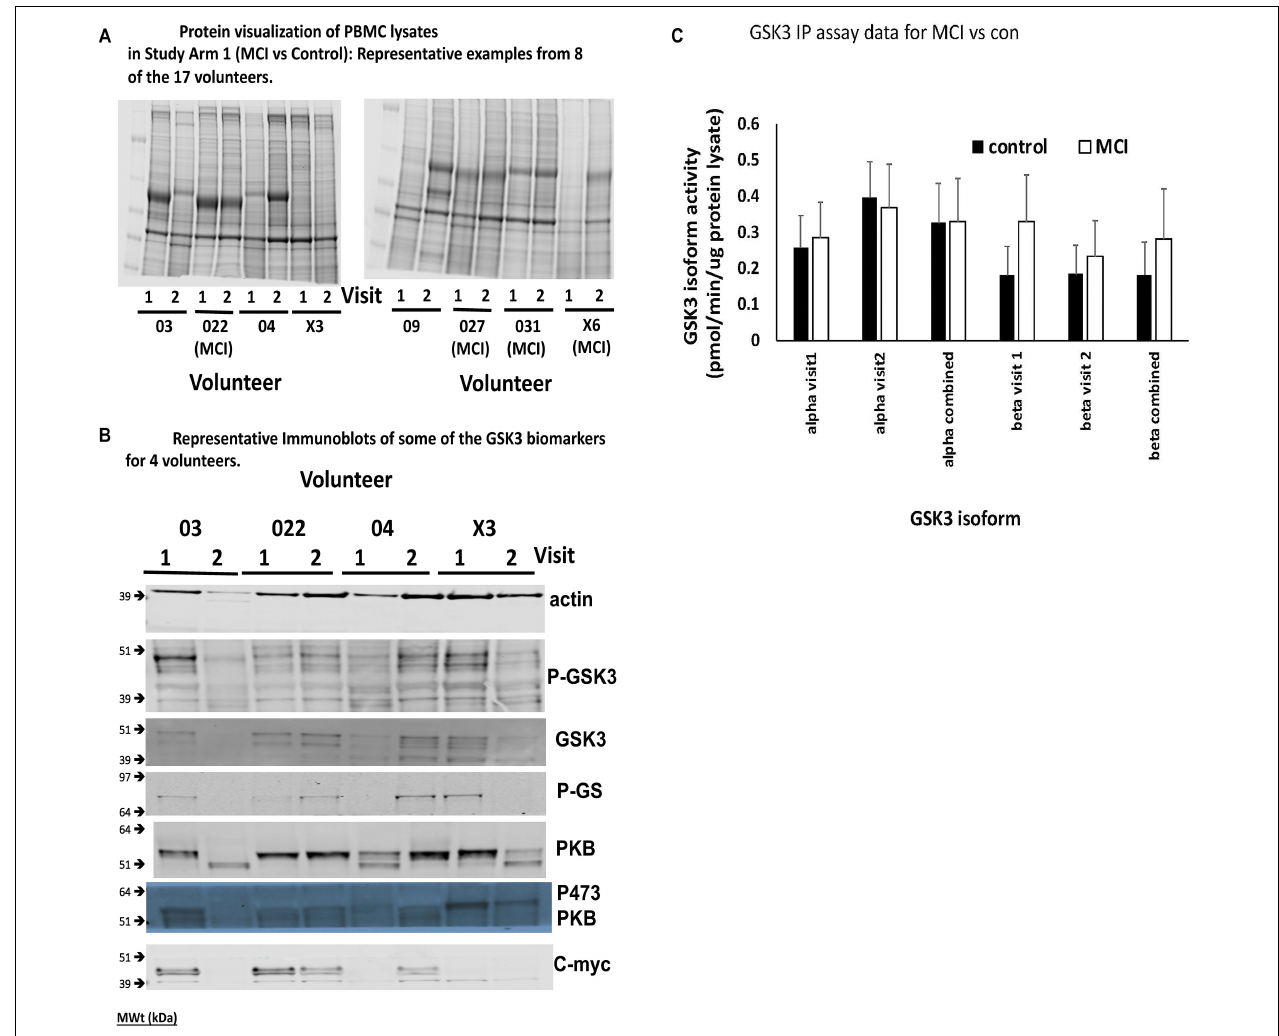
FIGURE 4 | Comparison of Biomarkers of GSK3 in human PBMCs isolated from volunteers with MCI and controls (Study Arm 1). Protein lysates were prepared from PBMCs isolated from two groups of human volunteers, one with a diagnosis of MCI, the other age matched but with no MCI. In each case the volunteer provided two blood samples for PBMC preparation, taken 12 weeks apart (Visit 1 and 2). (A) Representative Coomassie protein staining of PBMC lysates from 8 of the 17 volunteers in Study Arm 1, where equal total protein was loaded on the gel. (B) Representative immunoblots of biomarkers within the PBMCs of four of the volunteers in Study arm 1. (C) Immunoprecipitation and assay of GSK3 isoforms from 50 µ g of protein lysate in each of the PBMC samples. The specific activity was quantified for GSK3alpha and GSK3beta from all PBMC preparations and the average activity ( ± SE) for the MCI and control groups at each visit, as well as the two visits combined, is